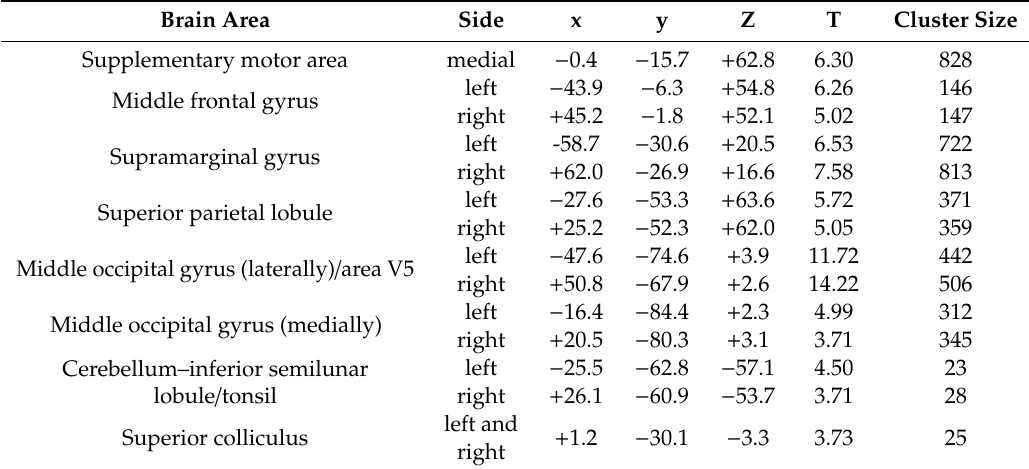
Table 4. Structures activated during the active contrast task in action observation together with motor imagery (AOMI) conditions.